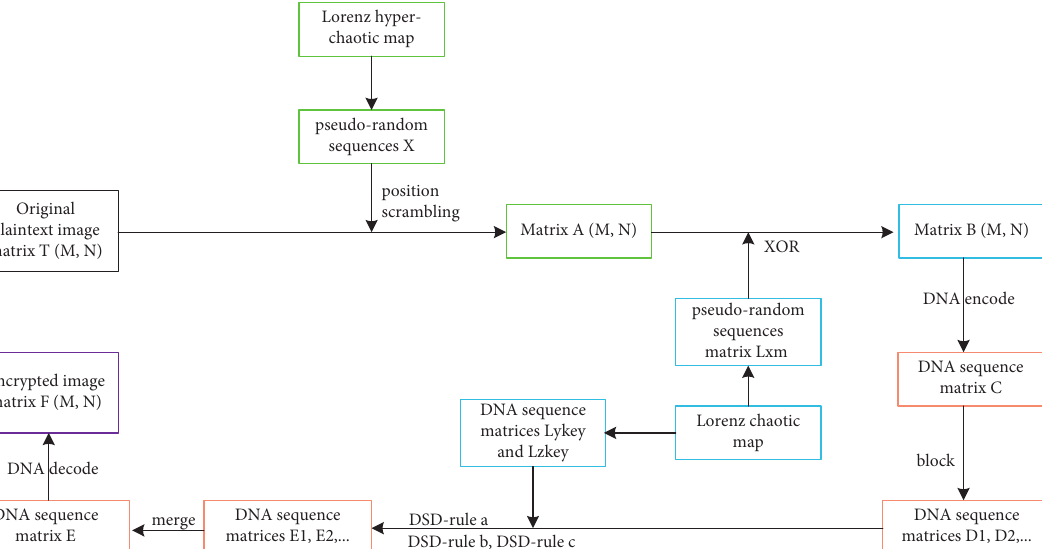
Figure 4: Flowchart of the proposed scheme.